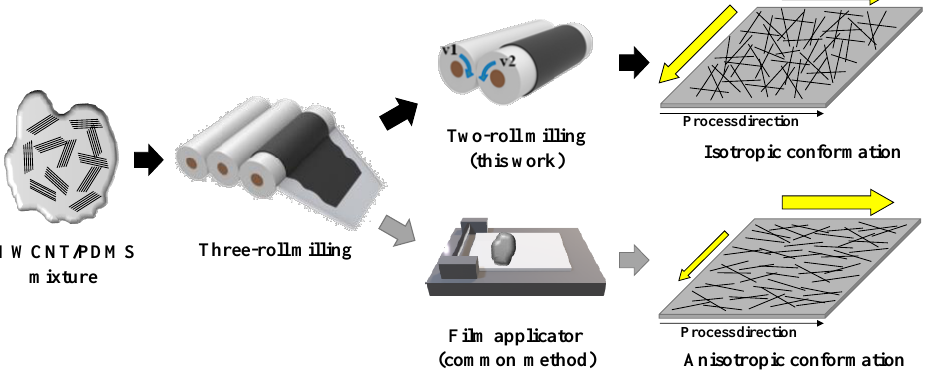
Figure 4. Schematic of MWCNT distribution conformation depending on the film-fabrication pro- cess.